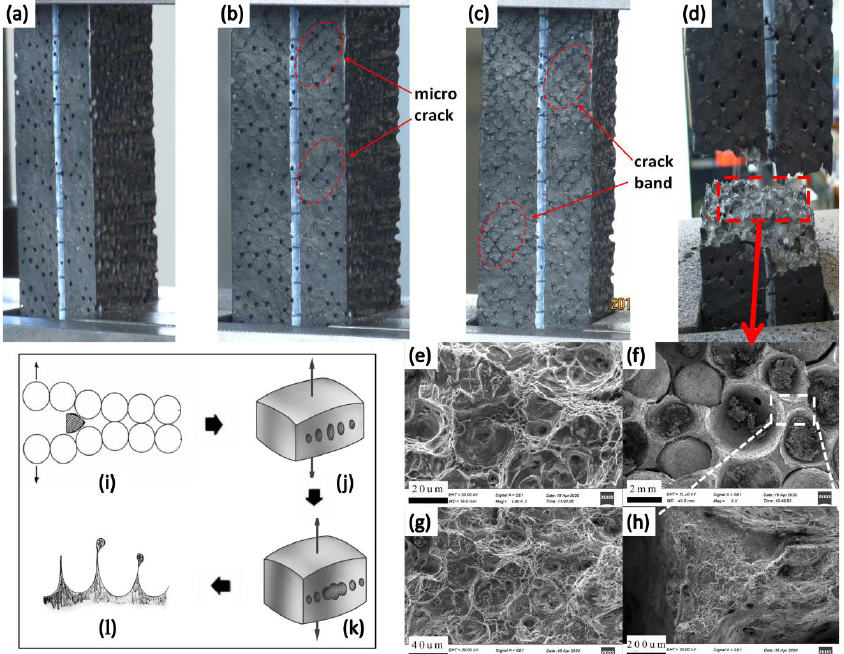
Figure 5. ( a – d ) Tensile test process of SSFs. ( e – h ) Tensile fracture morphology of SSFs. ( i – l ) Schematic views representing ductile-tensile fracture of SSFs.